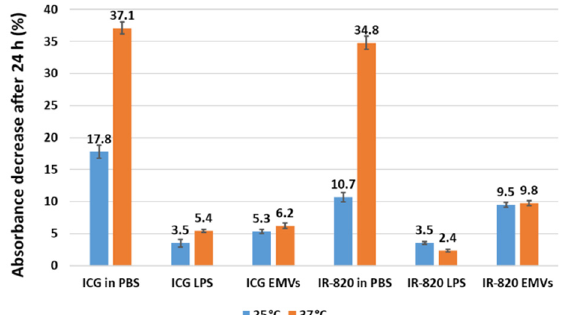
Figure 8. Temperature stability study of ICG- and IR-820-loaded carriers at 25 and 37 °C. Absorbance decrease (%) after 24 h incubation in the dark was calculated from the absorbance peak values measured before and after incubation. Measurements were performed in triplicate. Statistical analysis confirmed that the means of each data pair (sample at 25 and 37 °C) are not equal, and therefore, the absorbance values differ significantly ( p < 0.05), except for IR-820-loaded EMVs at 25 and 37 °C, where no statistically significant difference could be observed.